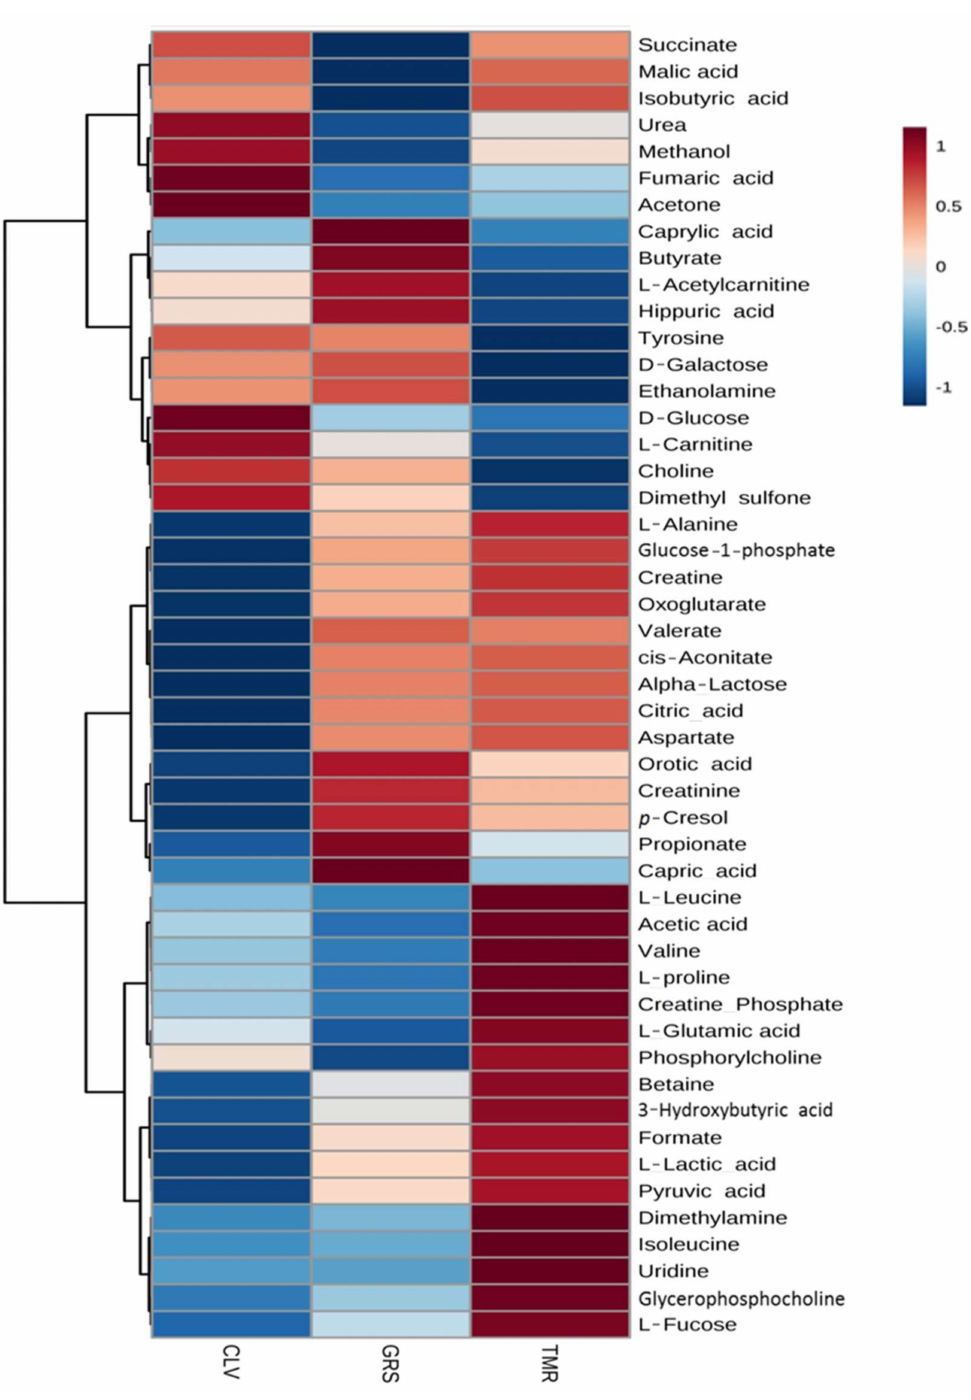
Figure 5. Hierarchical clustering analysis (heatmap) of average raw milk metabolites from mid-lactation cows fed diets consisting of total mixed ration (TMR), perennial ryegrass (GRS), or perennial ryegrass and white clover (CLV), as determined by 1 H-NMR. The degree of positive and negative correlation of metabolite to dietary system is indicated by +1 (red) to − 1